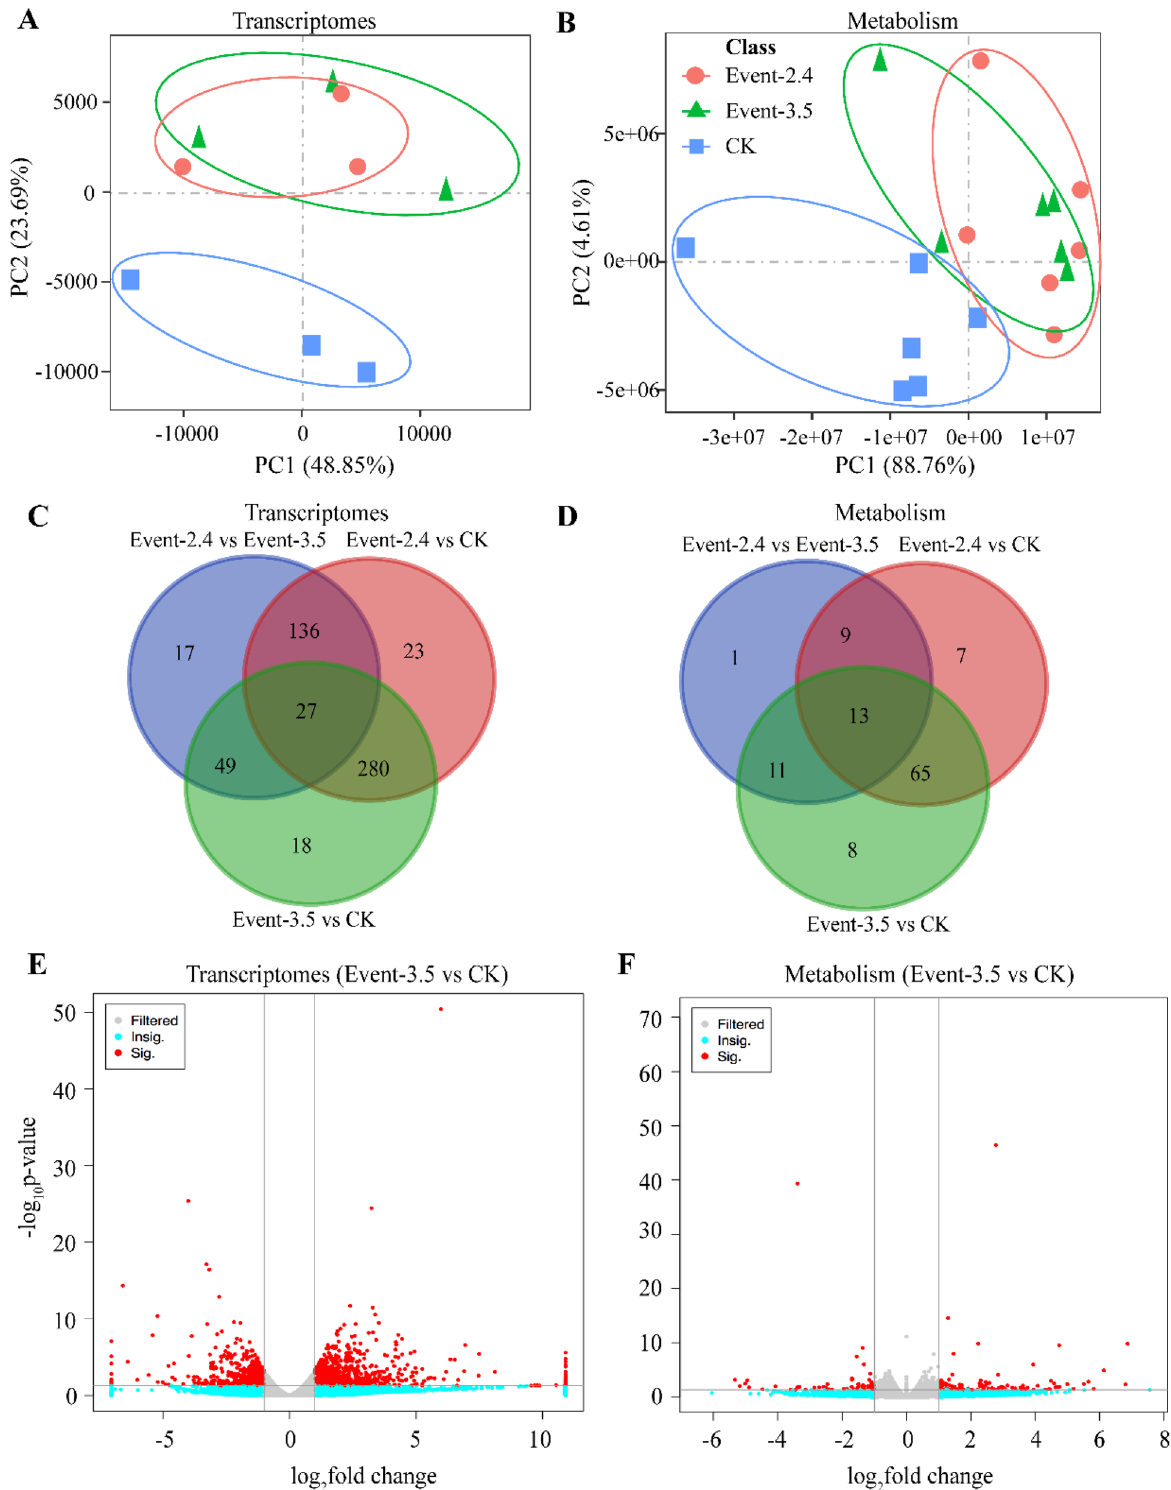
Figure 3. PCA analysis on differently abundant genes and metabolites in ZD958 maize transgenic lines grown in Beijing. ( A ), transcriptomes analysis on different experimental sites across different transgenic lines of transgenic event-2.4 (Event-2.4), transgenic event-3.5 (Event-3 . 5) and CK; n = 3. ( B ), metabolomic analysis on different experimental sites across different transgenic lines of 2.4, 3.5 and ck. n = 6. ( C ), overlapping genes between different ZD958 transgenic events and non-GM ZD958 (CK) grown in Beijing. The detailed overlapping genes are referred to Supplementary Table S2. ( D ), overlapping metabolites. The detailed overlapping metabolites are referred to Supplementary Table S3. ( E , F ), differential abundant genes and metabolites between event-3.5 and CK. The differential abundant genes (DAGs) and metabolites (DAMs) were indicated in red